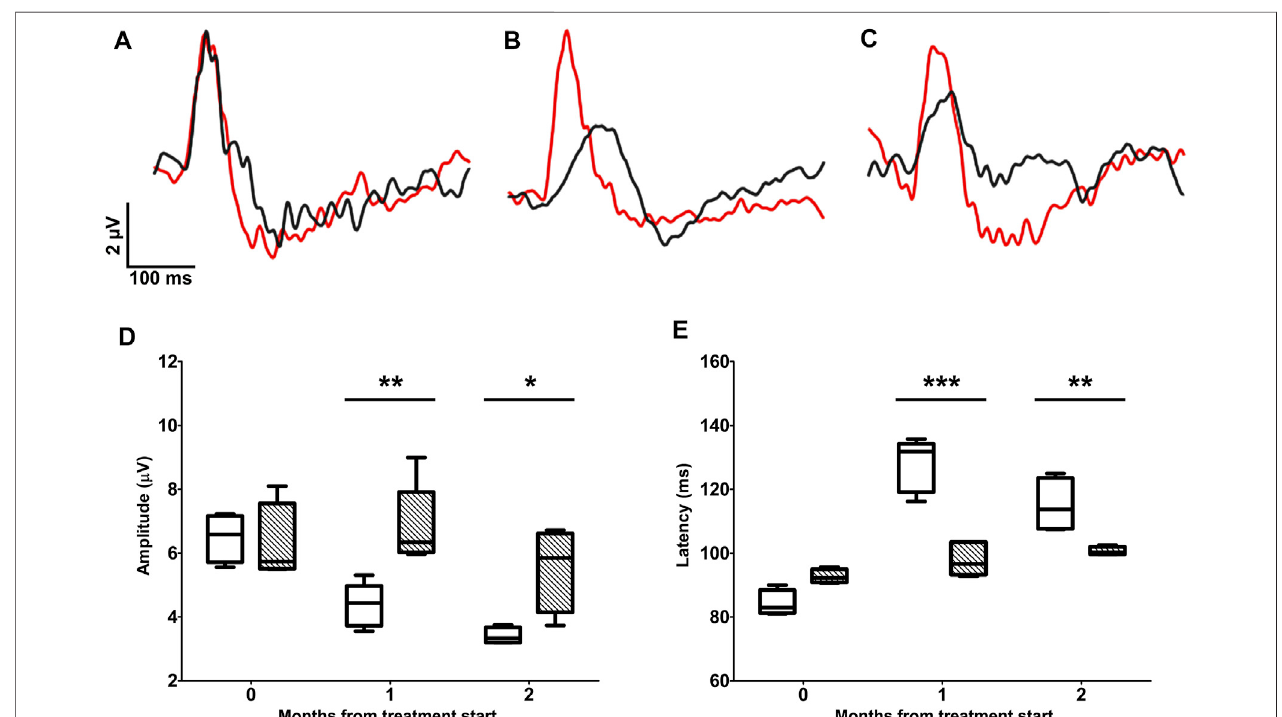
FIGURE 2 | Longitudinal evaluation ofRGC activity using PERG. PERG responses were recorded before the beginning ofthe treatment (A) and after 1 (B) or 2 (C) months of treatment in D2 (black traces) and D2+LG (red traces) mice. PERG responses were analyzed by retrieving the peak-to-trough amplitude and time-to-peak latency,as shown in theinset in (A) . The distribution ofPERG amplitudes (D) and PERG latencies (E) inD2 (white boxes) and D2+LG (dashed boxes) derivingfrom n (cid:1) 6 mice are shown by box plots. Statistical differences were tested using two-way ANOVA with Bonferroni post-hoc test. * p < 0.05, ** p < 0.01, *** p < 0.001.